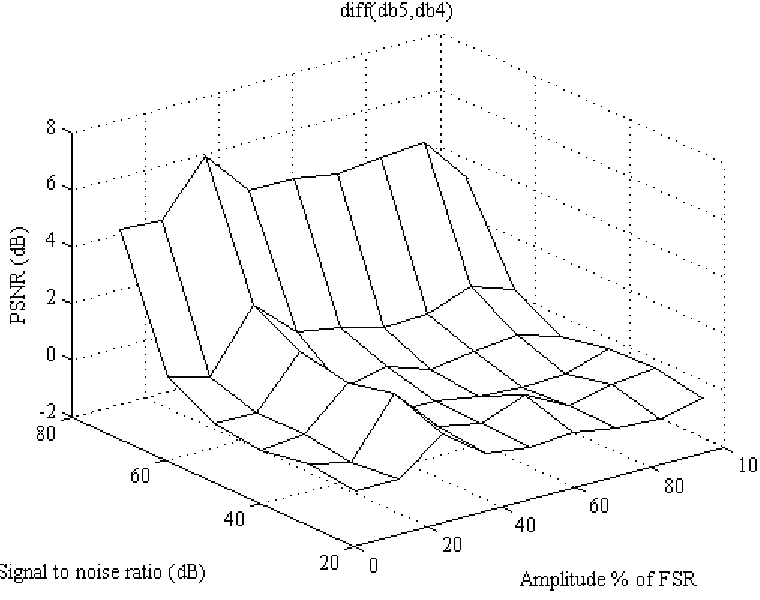
Figure 3. PSNR difference between db5 and db4.